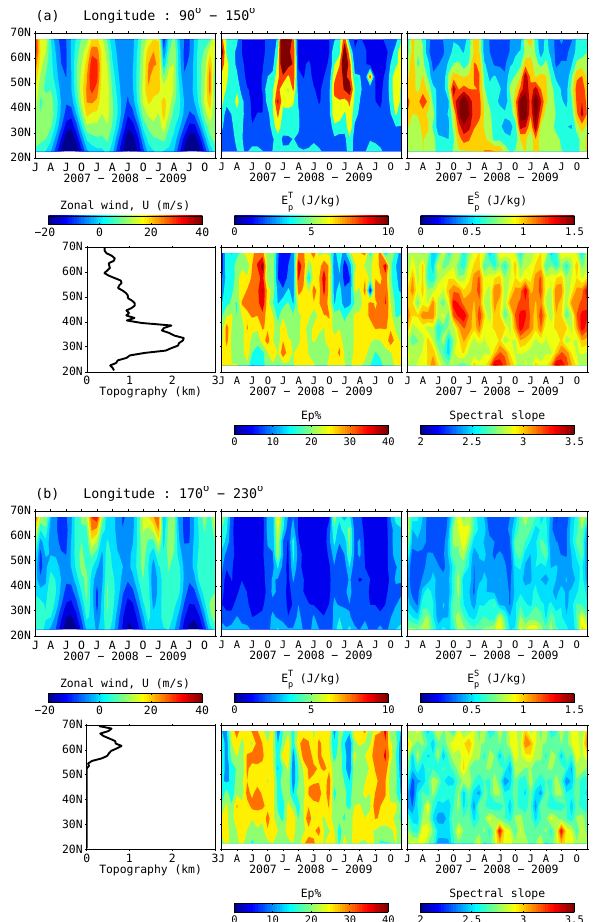
Figure 6. Latitude–time variations in GW parameters in the NH (20–70 ◦ N) in longitude regions (a) and (b). In the top row in (a) and (b) , panels are U , E T p , and E S p from left to right. In the bot- tom row, the leftmost panel shows the mean of topography with 1 ◦ latitude resolution averaged in the selected longitude regions, and the second and third panels are E p % and the absolute value of p ,